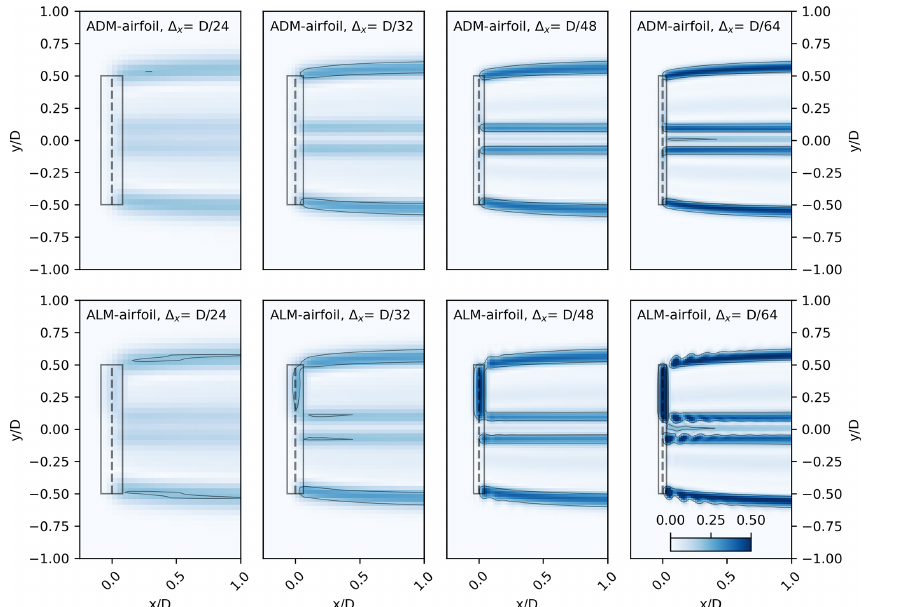
Figure A1. Mesh sensitivity study for the ADM-airfoil and the ALM-airfoil: instantaneous vorticity on a plane at hub height. Part of the extension of the force distributions is marked with a rectangle, assigning a total rectangle width of 2 ε .